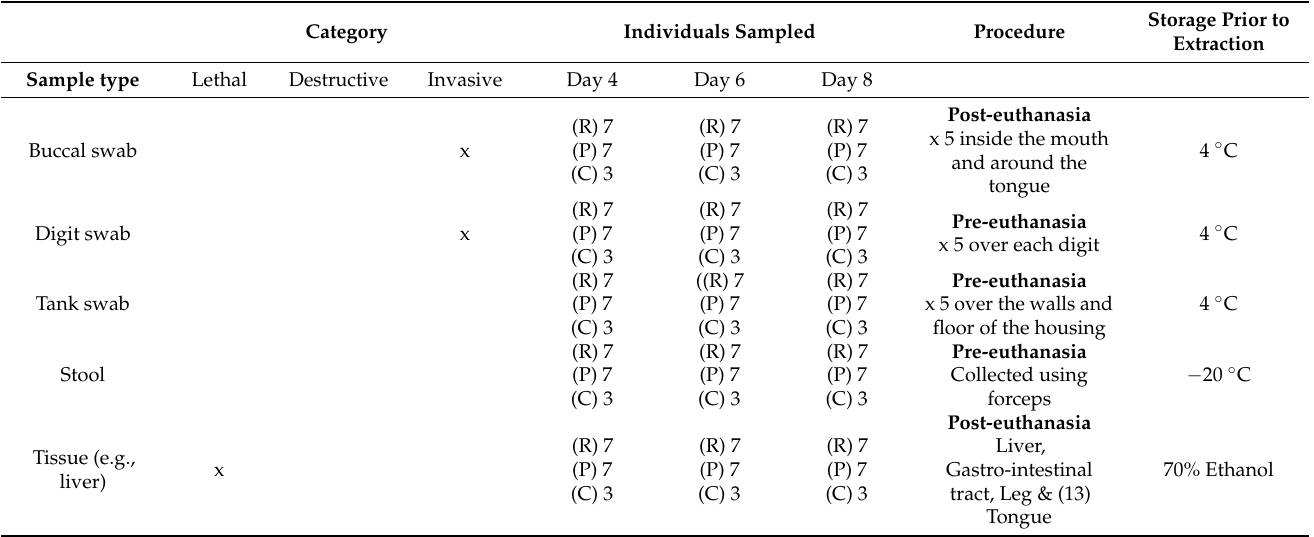
Table 2. Sampling techniques undertaken on B. bufo throughout the experiment. (R) = RUK13, (P) = PDE18, (C) =